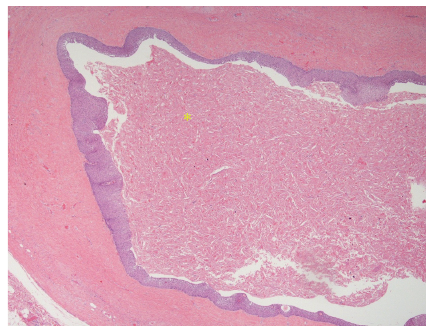
Figure 7: H&E 10x image showing abundant keratin debris ( ∗ ) within the cyst.